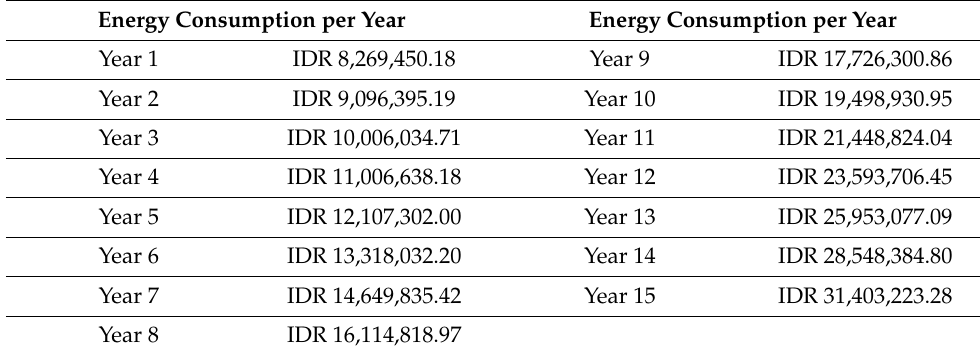
Table 9. Energy consumption every year for 15 years.